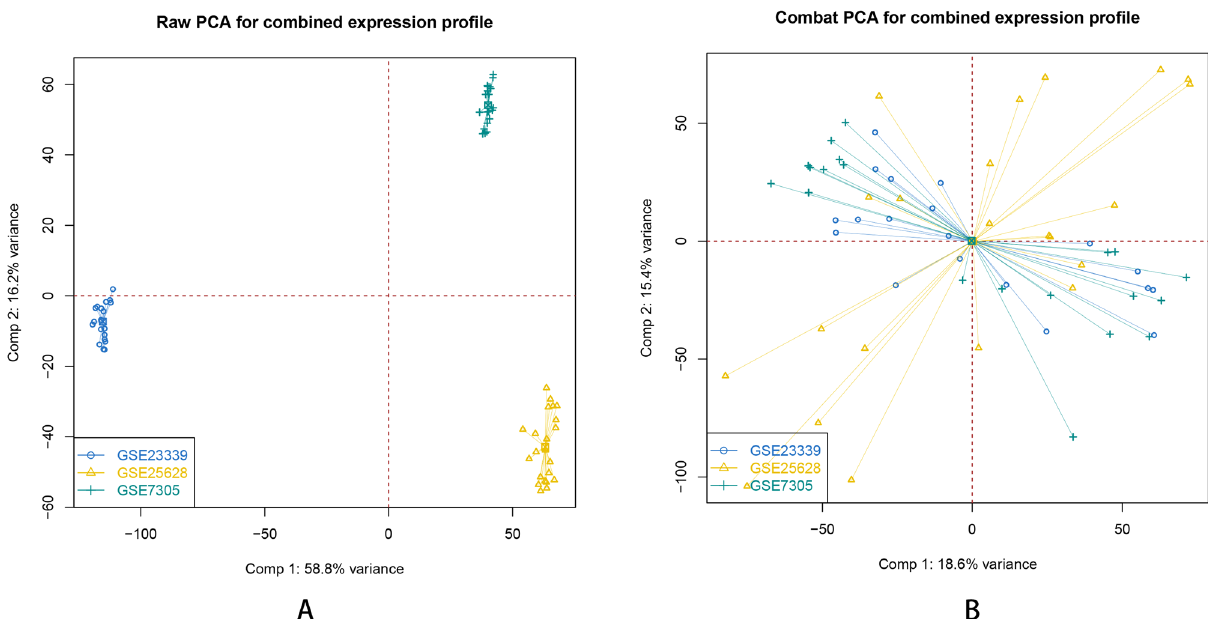
Figure 2. Principal Component Analysis for combined expression profile of each data set. ( A ) raw PCA for combined expression profile before eliminating the inter-batch difference. ( B ) combat PCA for combined expression profile after eliminating the inter-batch difference.